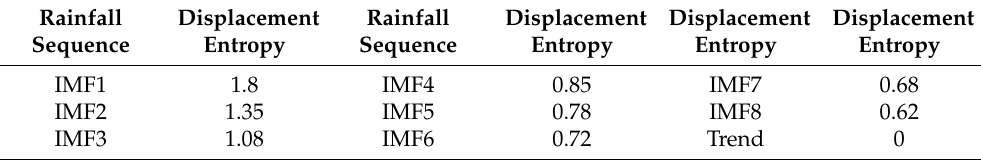
Table 2. Trend of IMF components and trend term entropy after CEEMD decomposition.